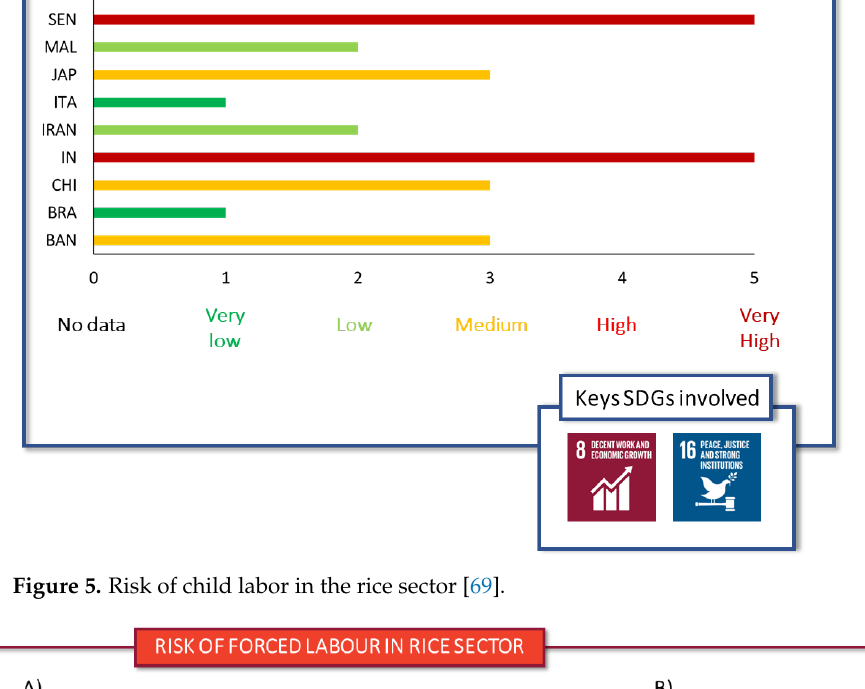
Figure 5. Risk of child labor in the rice sector [69].